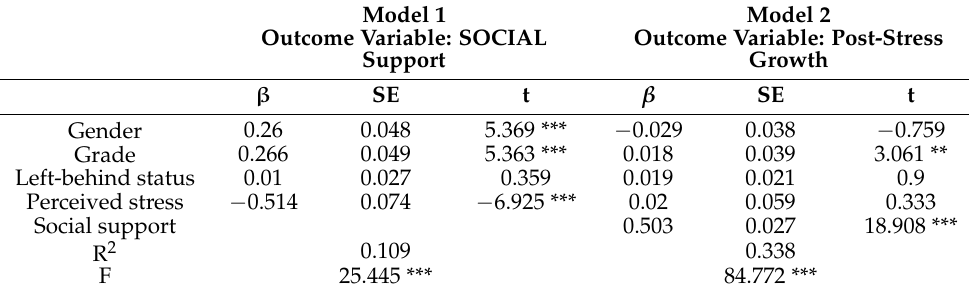
Table 3. Results of the mediation